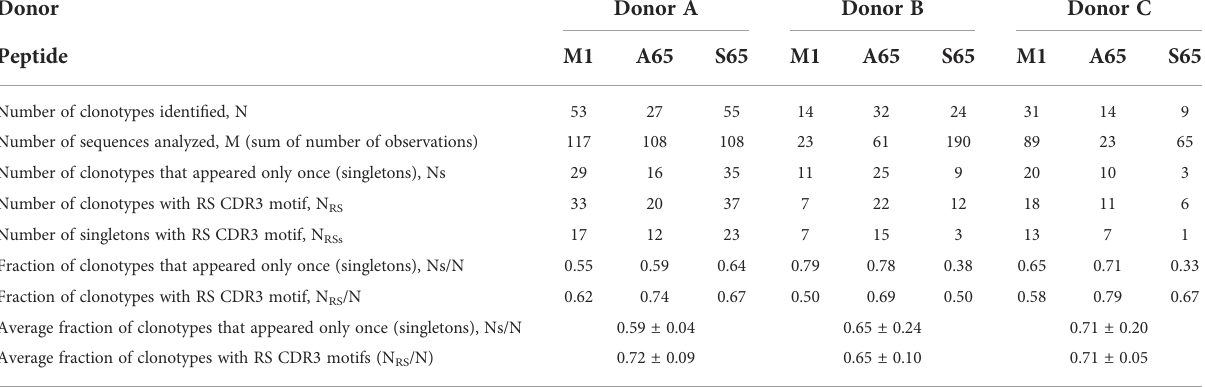
TABLE 5 Non-cross- reactive repertoire characteristics and summaries for each donor and each peptide.